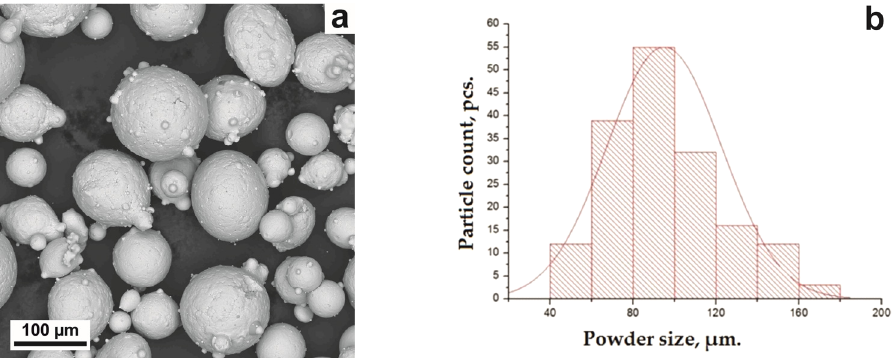
Figure 1. Powder 09CrNi2MoCu: ( a ) surface of powder particles; ( b ) histogram of the powder size.